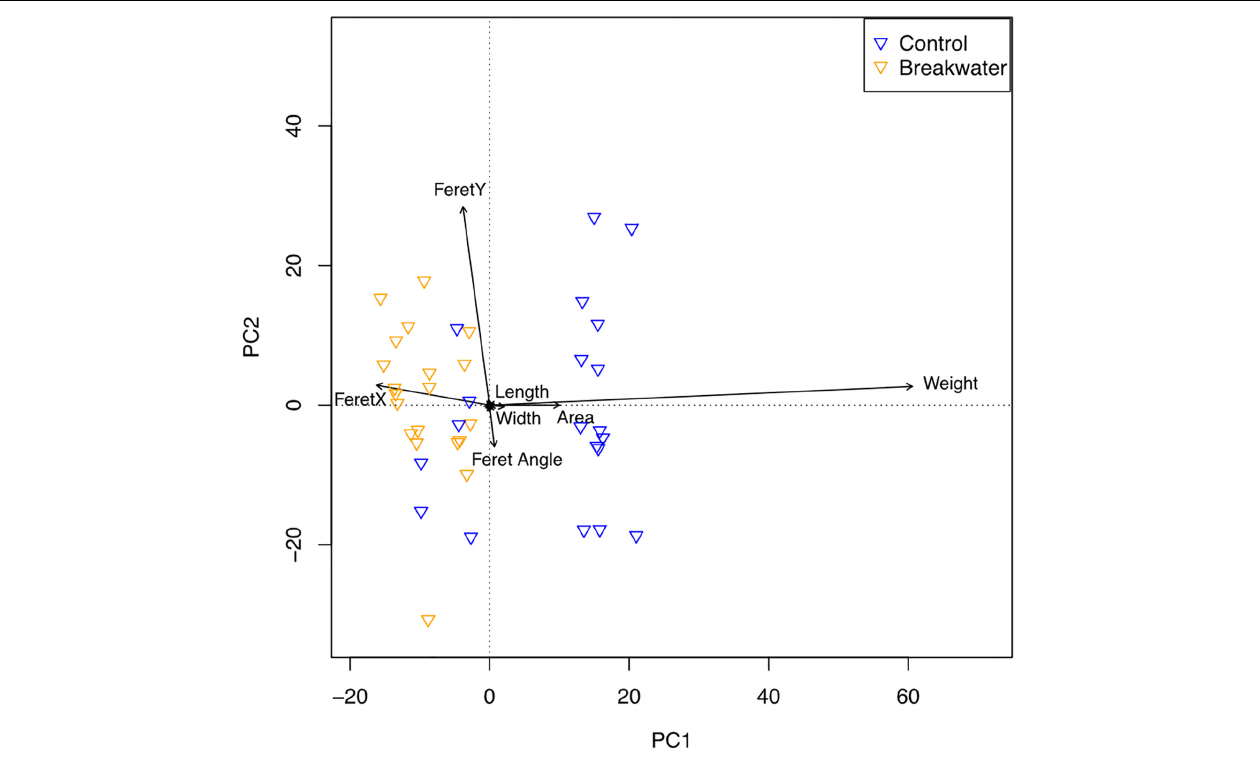
FIGURE 5 | Principal Component Analysis (PCA) biplot of coral rubble spatial complexity at the breakwater and control sites. Arrow directions points toward stronger